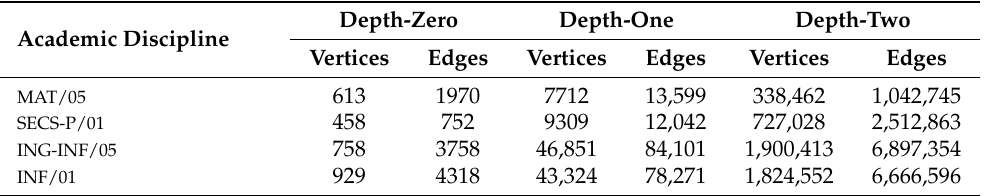
Table 3. Giant Connected Components size of the Italian co-authorship networks of the academic disciplines under